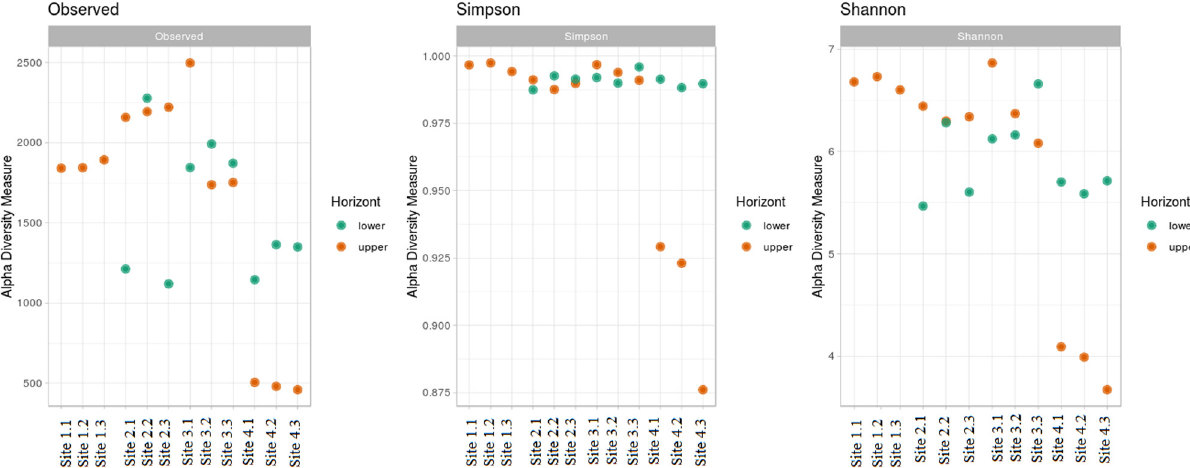
Figure 3: Alpha biodiversity of investigated